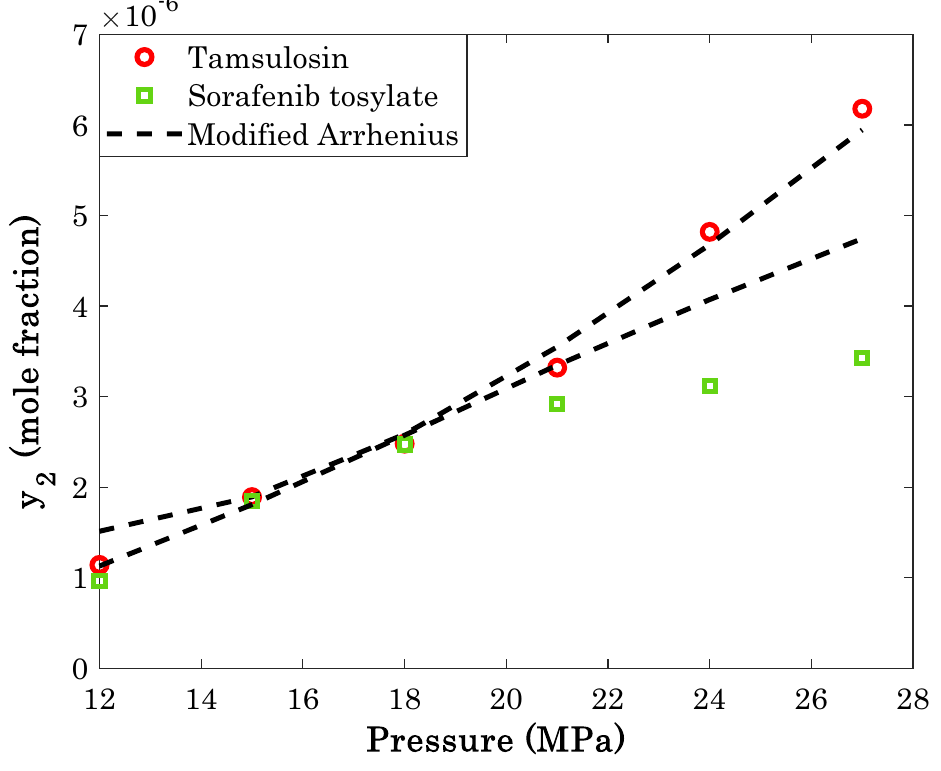
Figure 14. The smallest amount of drug solubility in SCCO 2 at temperature = 318